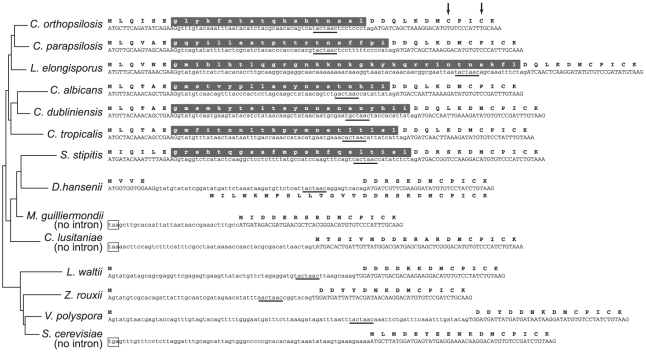
Potential in-frame translation of unspliced introns in Candida TFB3 genes.The 5′ end of TFB3 genes from 14 yeast species are shown, ending at a conserved region coding for the amino acid sequence DMCPICK. Exons and introns are written in upper and lower case, respectively. Gray backgrounds indicate potential in-frame translation of introns. Spliced and unspliced mRNAs have been identified in three species: C. orthopsilosis, C. parapsilosis and C. albicans. Probable intron branch sites are underlined. Upstream in-frame stop codons are boxed. Two possible alternative gene structures are shown for D. hansenii. Arrows mark two Cys residues that form part of the RING finger domain. The topology of the phylogenetic tree is from Fitzpatrick et al [126].